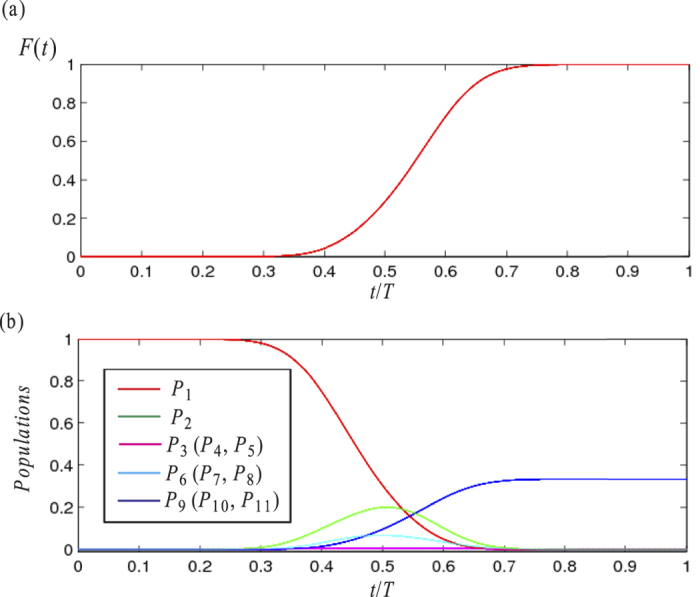
(a) The fidelity F(t) versus t/T. (b) The population Pm of  versus t/T.